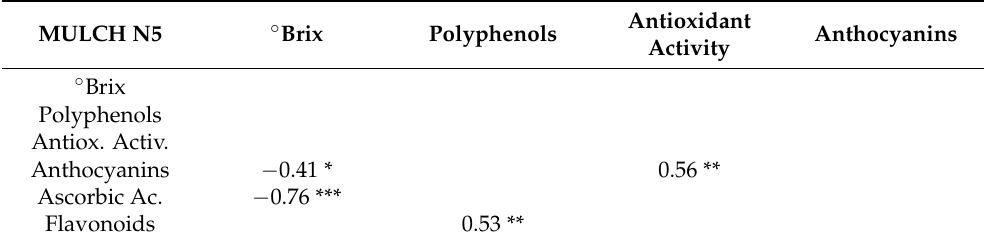
Table 3. Significant Pearson correlation coefficients among qualitative and nutraceutical traits mea- sured both in ‘Sabrina’ and ‘Elide’ as the mulching films changes ( n = 24). Significance: *** significant for p ≤ 0.001; ** significant for p ≤ 0.01; * significant for p ≤